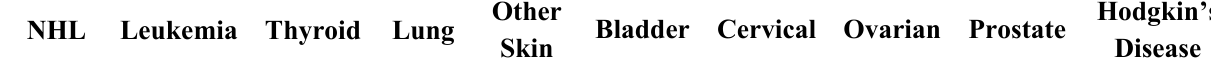
Table 3. Coefficients of determination (r²) derived from OLS